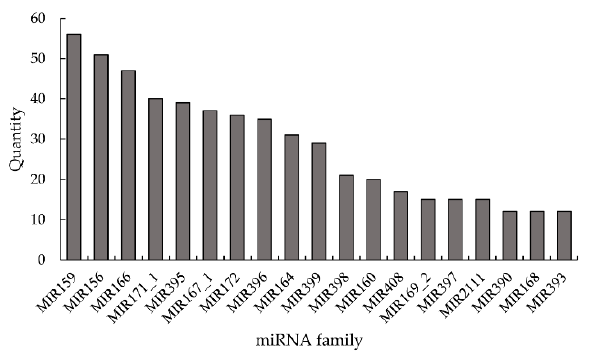
Figure 2. The number of miRNAs belonging to the top 19 miRNA families.